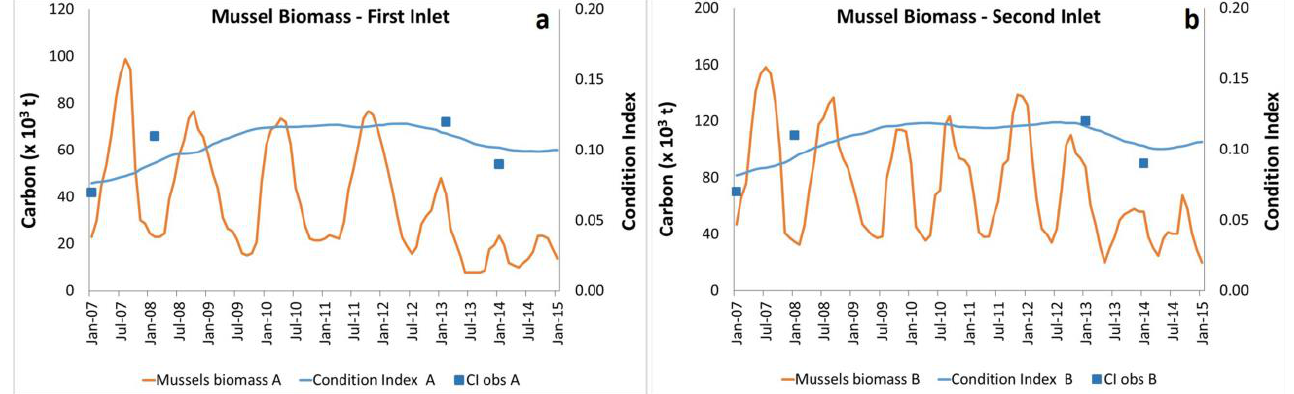
Figure 9. Simulation of the mussel biomass (wet weight of 10 3 t of Carbon), Condition Index predic-